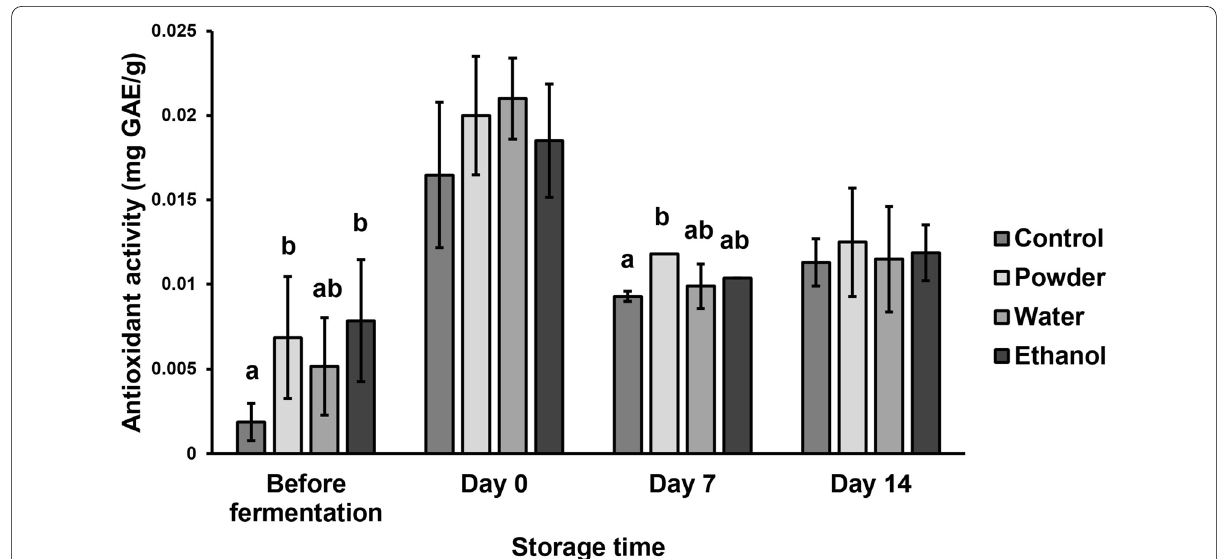
Fig. 2 Antioxidant activity of yogurt samples during storage (4 °C). Bars within each storage time with different letters are significantly different ( p <